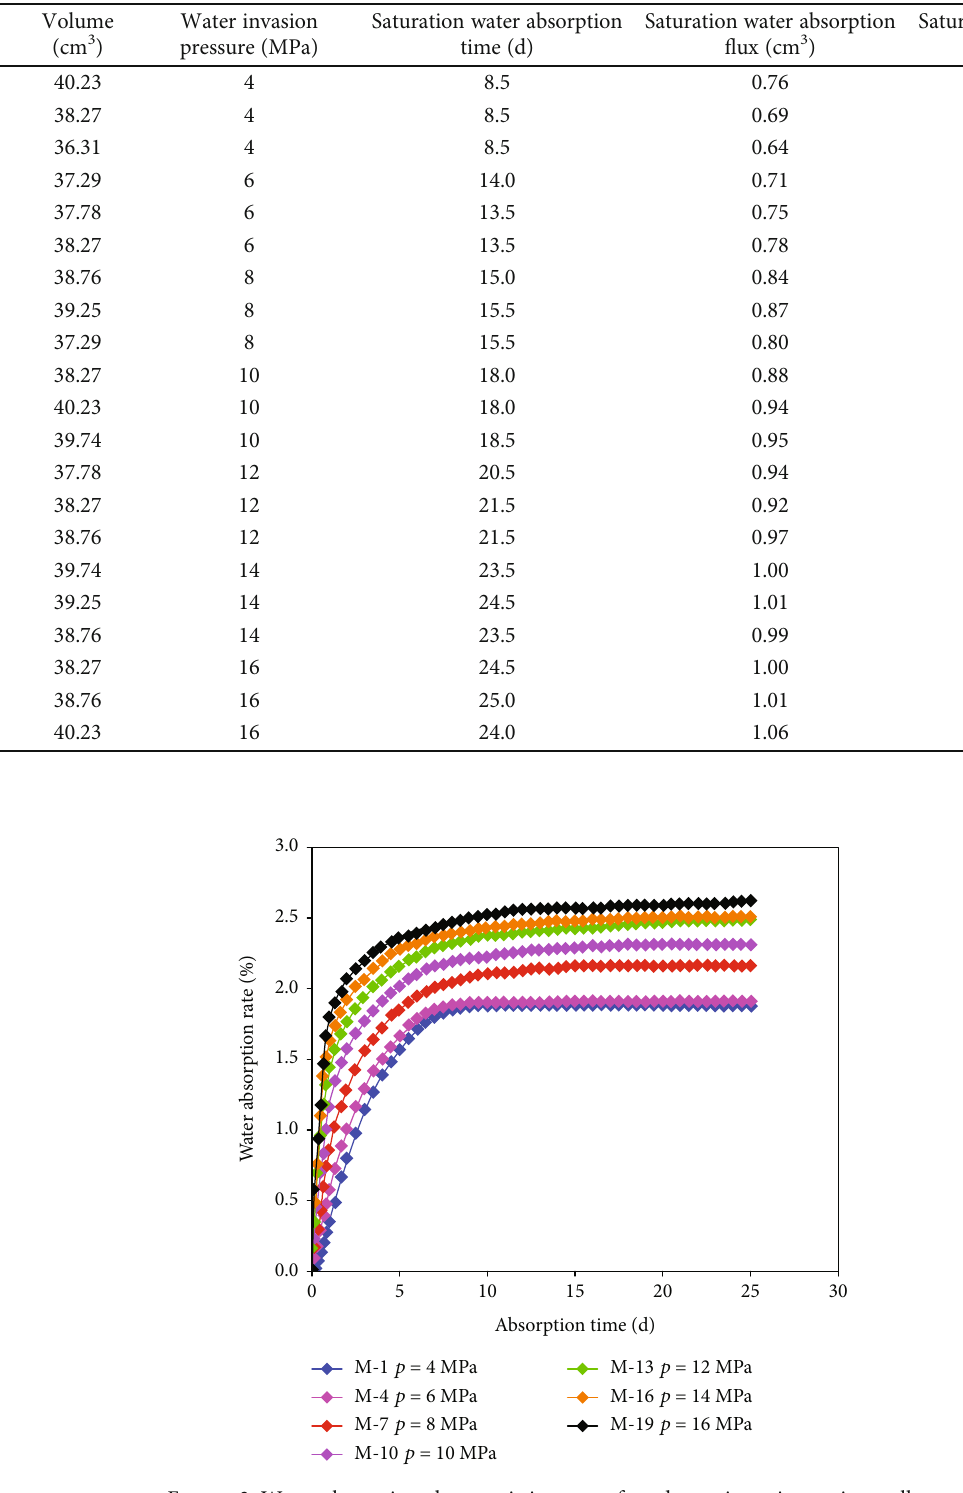
Figure 2: Water absorption characteristic curve of mudstone in an inspection